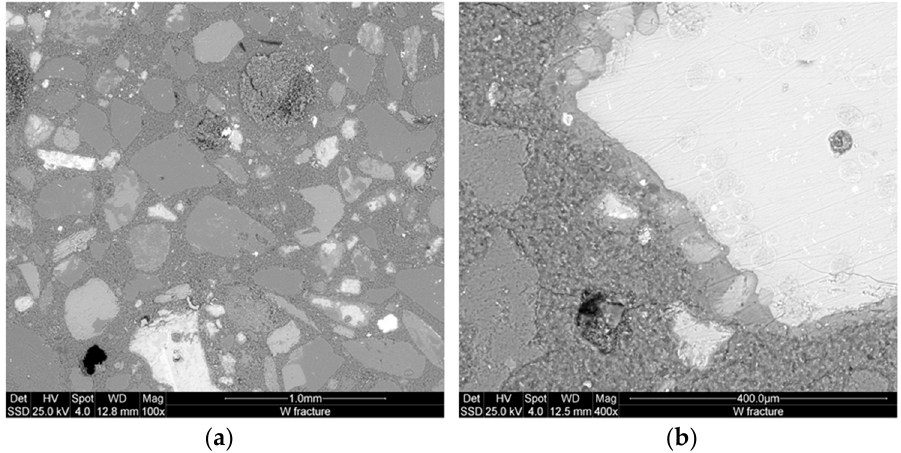
Figure 8. ESEM microstructure of white slag-based AAS mortars showing: ( a ) overall microstructure with quartz and iron-rich aggregates (solid solution) embedded into the matrix; ( b ) interface zone demonstrating good adhesion bonds between the various aggregates and the matrix.